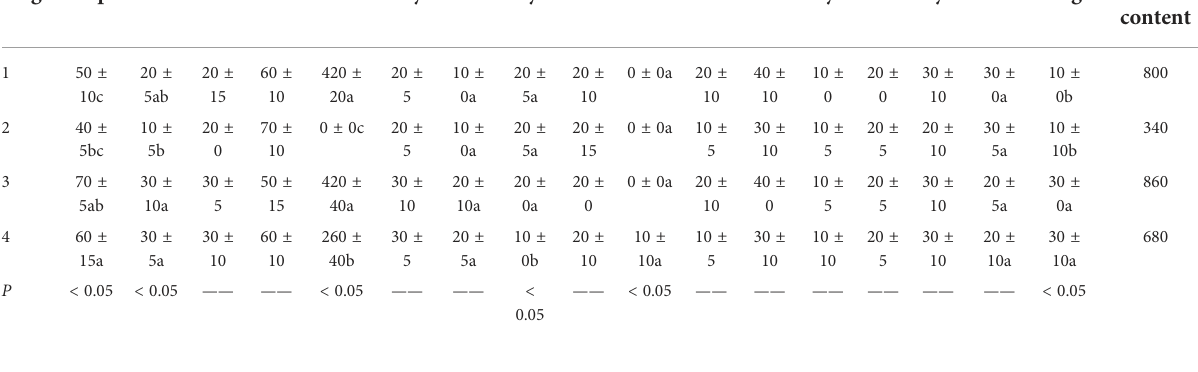
TABLE 10 The content of amino acid in the pulp at different developmental stages of fruit(mg/100g). Stage